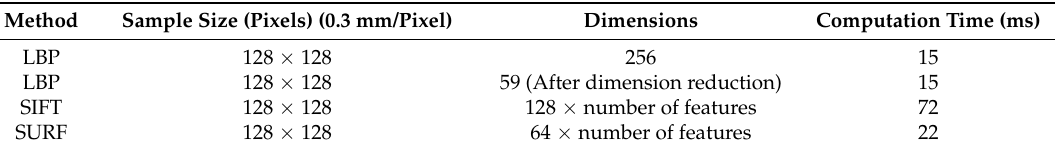
Table 2. Comparison of average computation time among LBP, SIFT and SURF.